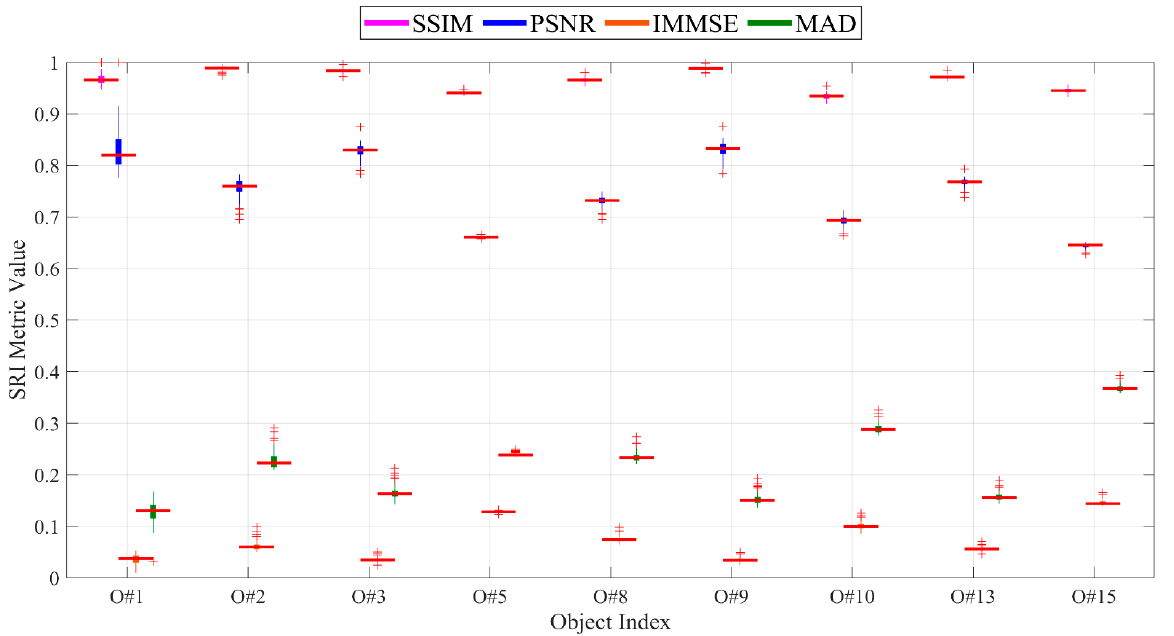
Figure 14. Evaluation results for SRI performances of proposed method for 122 specular reflection suppressed images (121 sub-aperture + 1 maximum ones) of nine sample objects separately using different SRI metrics.